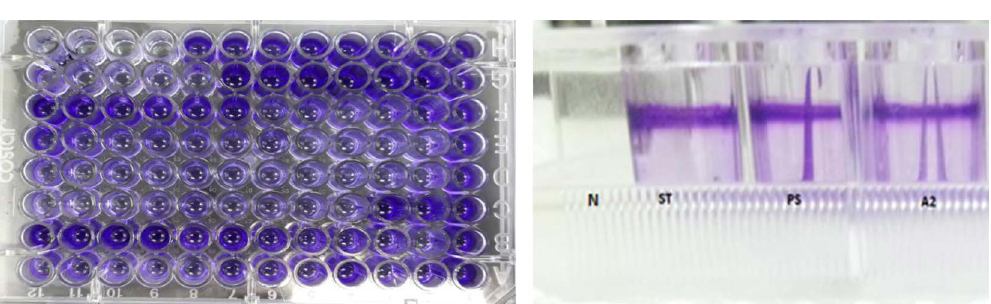
Fig. 3. Isolates (ST, A2 and PS) showed strong biofilm formation by TCP. While N showed non- biofilm formation.